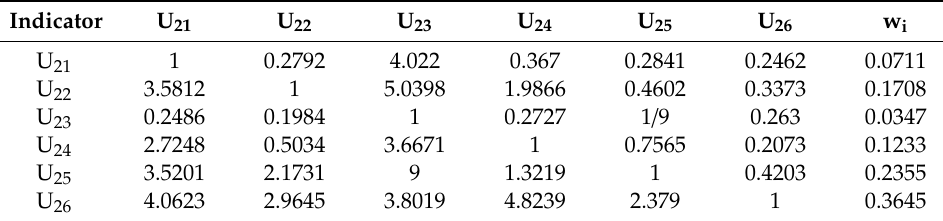
Table 6. Economic benefit modified weight matrix.